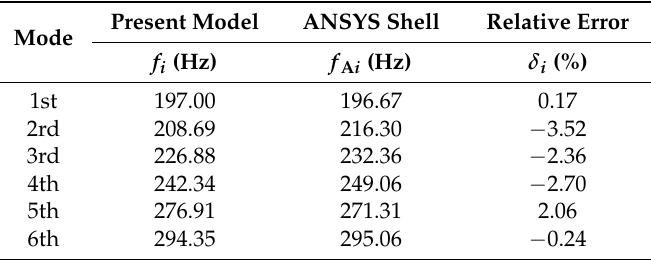
Table 2. Comparison of the first six natural frequencies of the fixed–fixed thin-walled